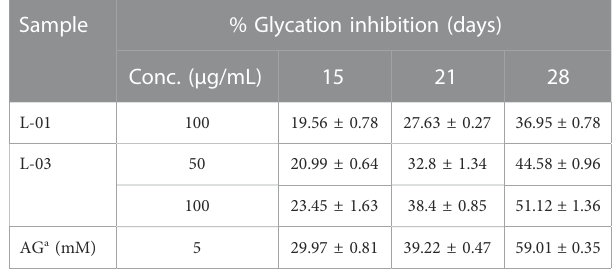
TABLE 1 Percent inhibition of fl uorescent AGEs by L-01 and L-03 (in glycated BSA) over 15 – 28 days of incubation.